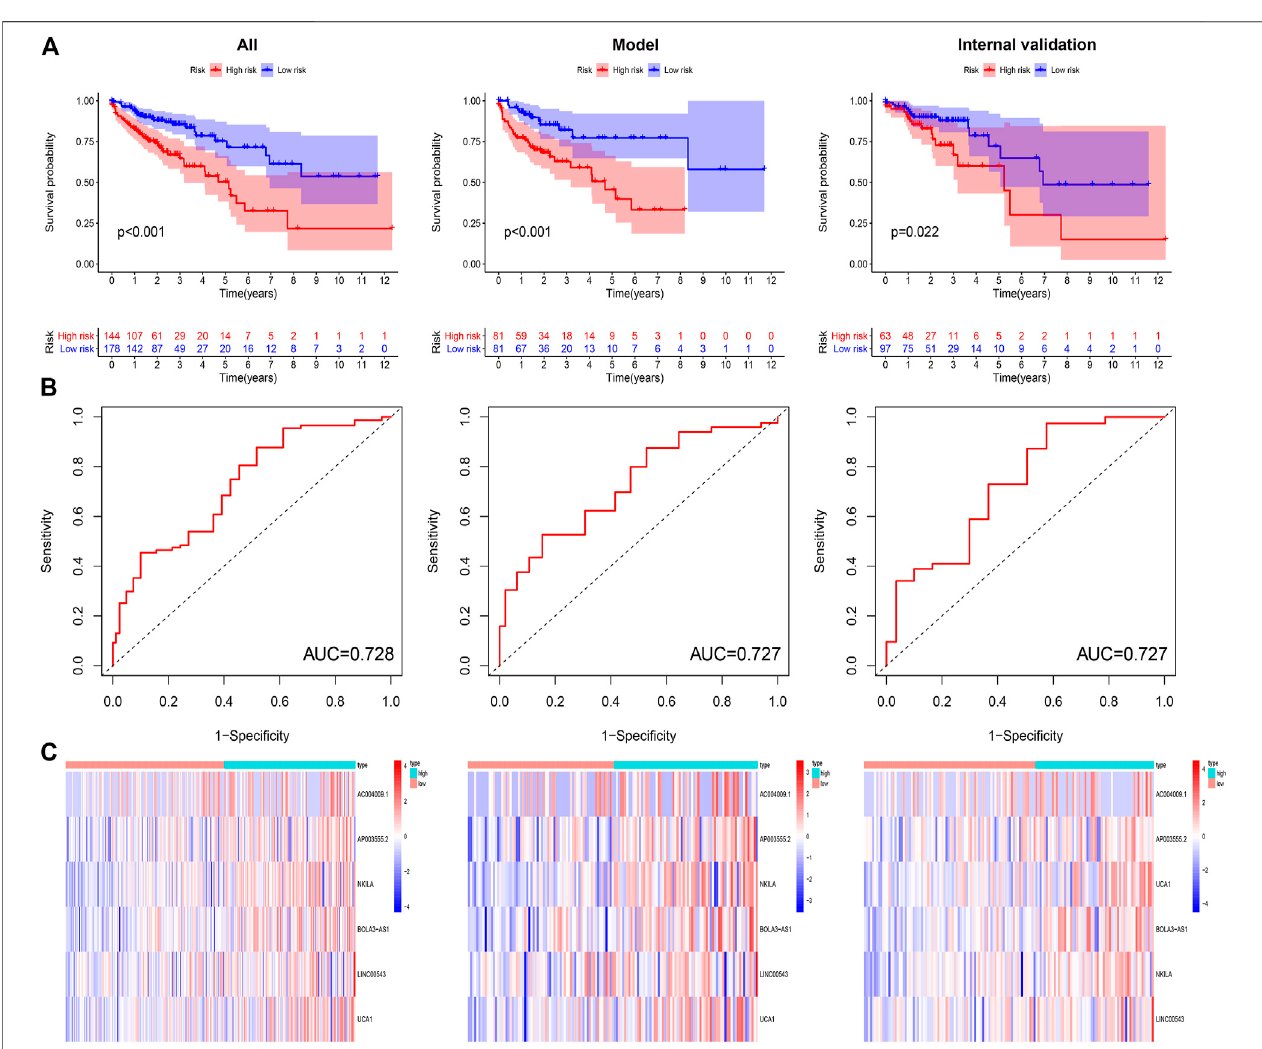
FIGURE 3 | (A) Kaplan – Meier curves of overall survival in different groups. (B) ROC curves in different groups. (C) The heat map of six key lncRNA expression patterns with increasing risk score. ROC: receiver operating characteristics.